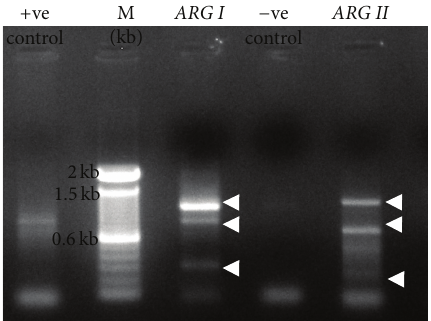
Figure 6: RT-PCR analysis of ARG I and ARG II transcripts. Three ARG I (1000bp, 800 bp, and 300bp) and three ARG II (1200bp, 700 bp, and 300 bp) transcripts were indicated by arrow. Bp showed marker, ARG I = arginase-I, and ARG II = arginase-II. Negative control is reaction mixture without template and positive control primers provided by the